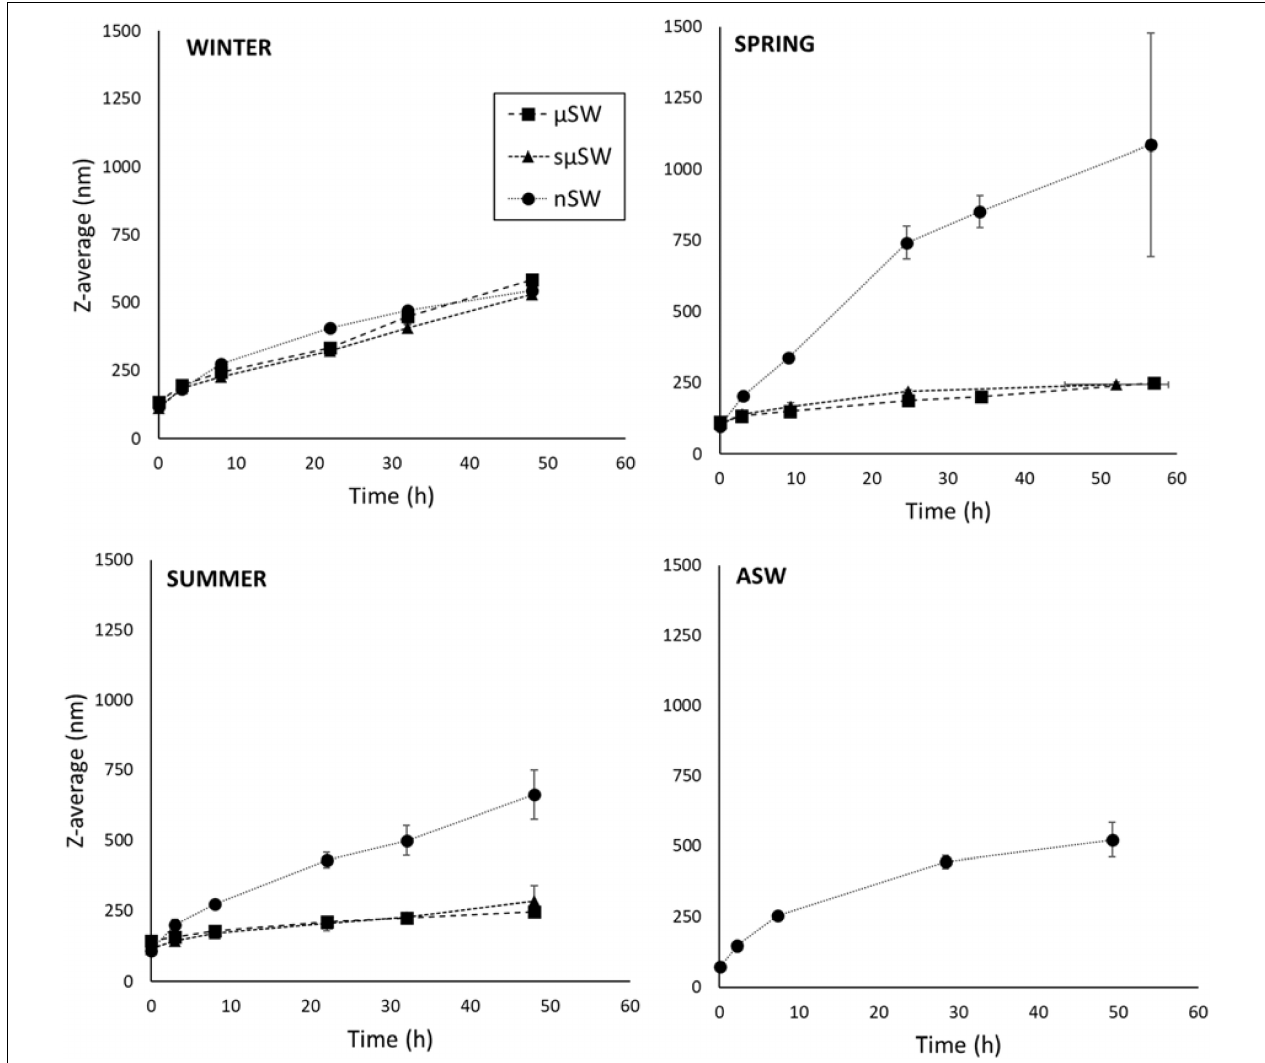
FIGURE 2 | Z-average measured with DLS over time for Au ENPs in seawater collected during the winter, spring, and summer and filtered through 5 µ m ( µ SW), 0.45 µ m (s µ SW), and 0.02 µ m (nSW) pore size membrane. Identical experiments in artificial seawater (ASW) are also